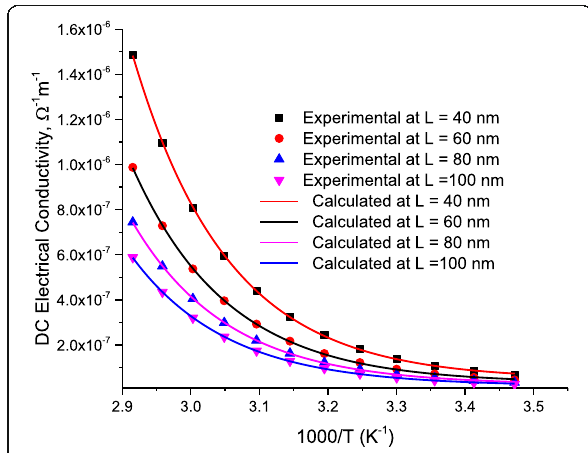
Fig. 12 DC-electrical conductivity, calculated from Eq. (6-a), as a function of temperature for different DNA-lengths